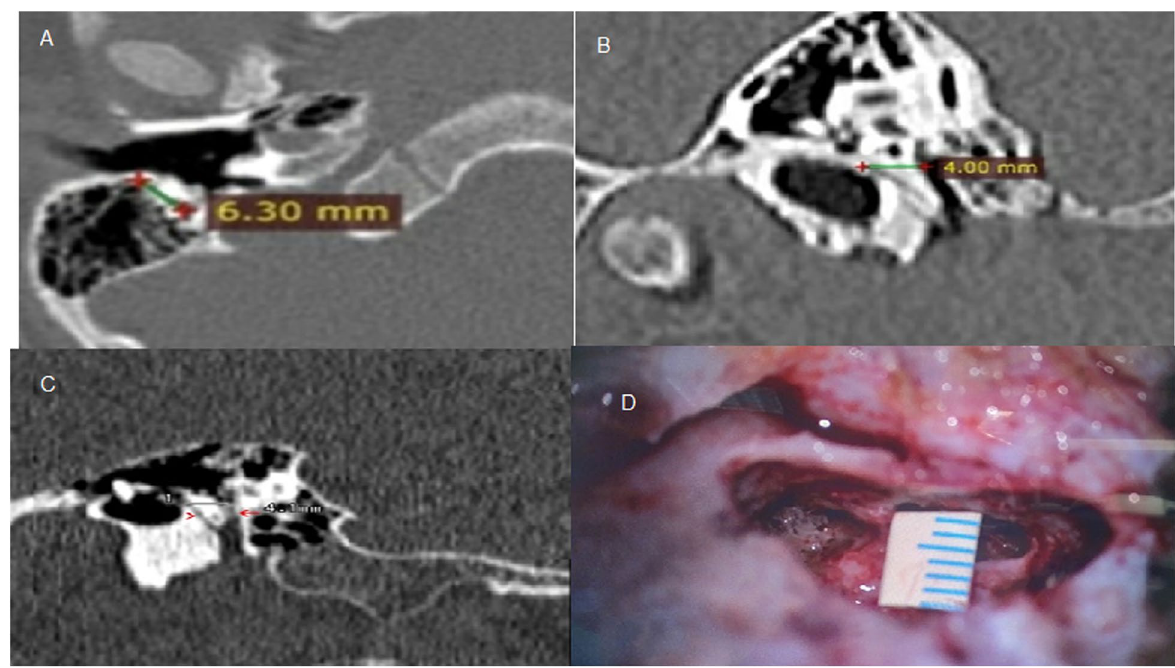
Fig. 1 A High-resolution computed tomography (HRCT) axial cut showing right (RT) facial recess width of 6.30, B HRCT oblique sagittal cut (MPR) showing facial recess width of 4.00 mm, C HRCT curved MPR image showing facial recess width of 4.1 mm, facial nerve (arrow), and chorda tympani (head arrow), and D intraoperative view showing right facial recess width of 4 mm